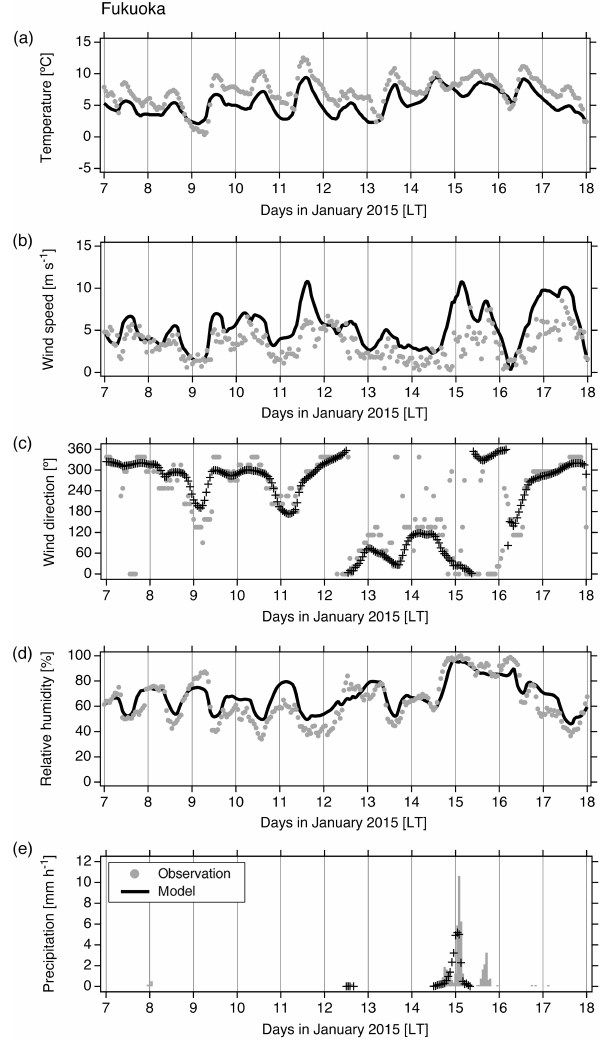
Figure 4. The temporal variation in (a) temperature, (b) wind speed, (c) wind direction, (d) relative humidity, and (e) precipitation at Fukuoka from 7–17 January 2015. The gray and black coloring in- dicates the observations and the model results,